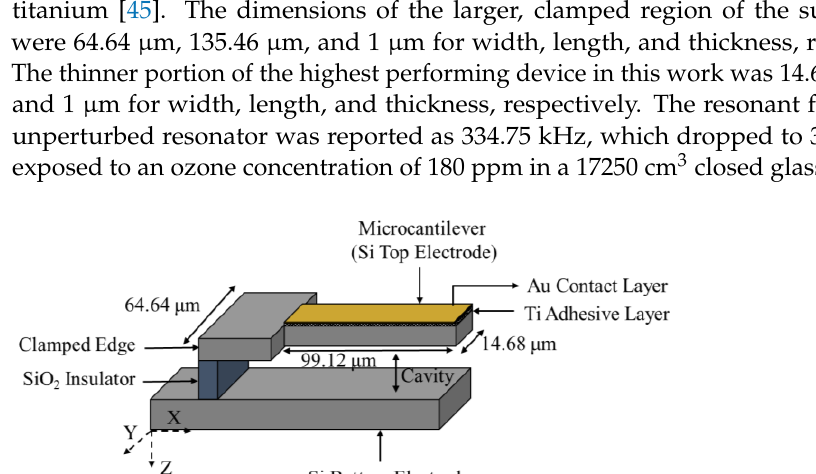
Figure 8. Schematic view of a microchannel microcantilever structure (image not to scale).